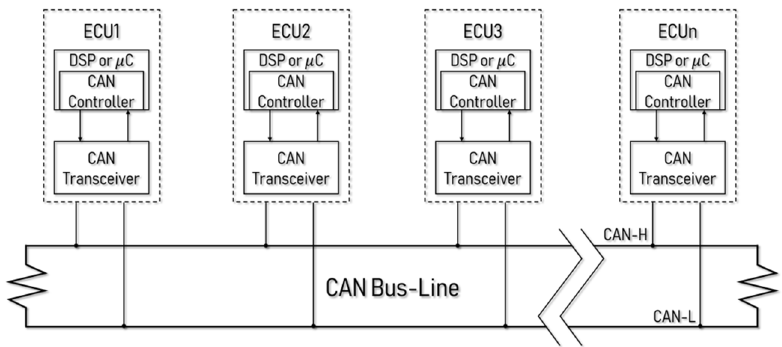
Figure 1. The controller area network (CAN) structures.